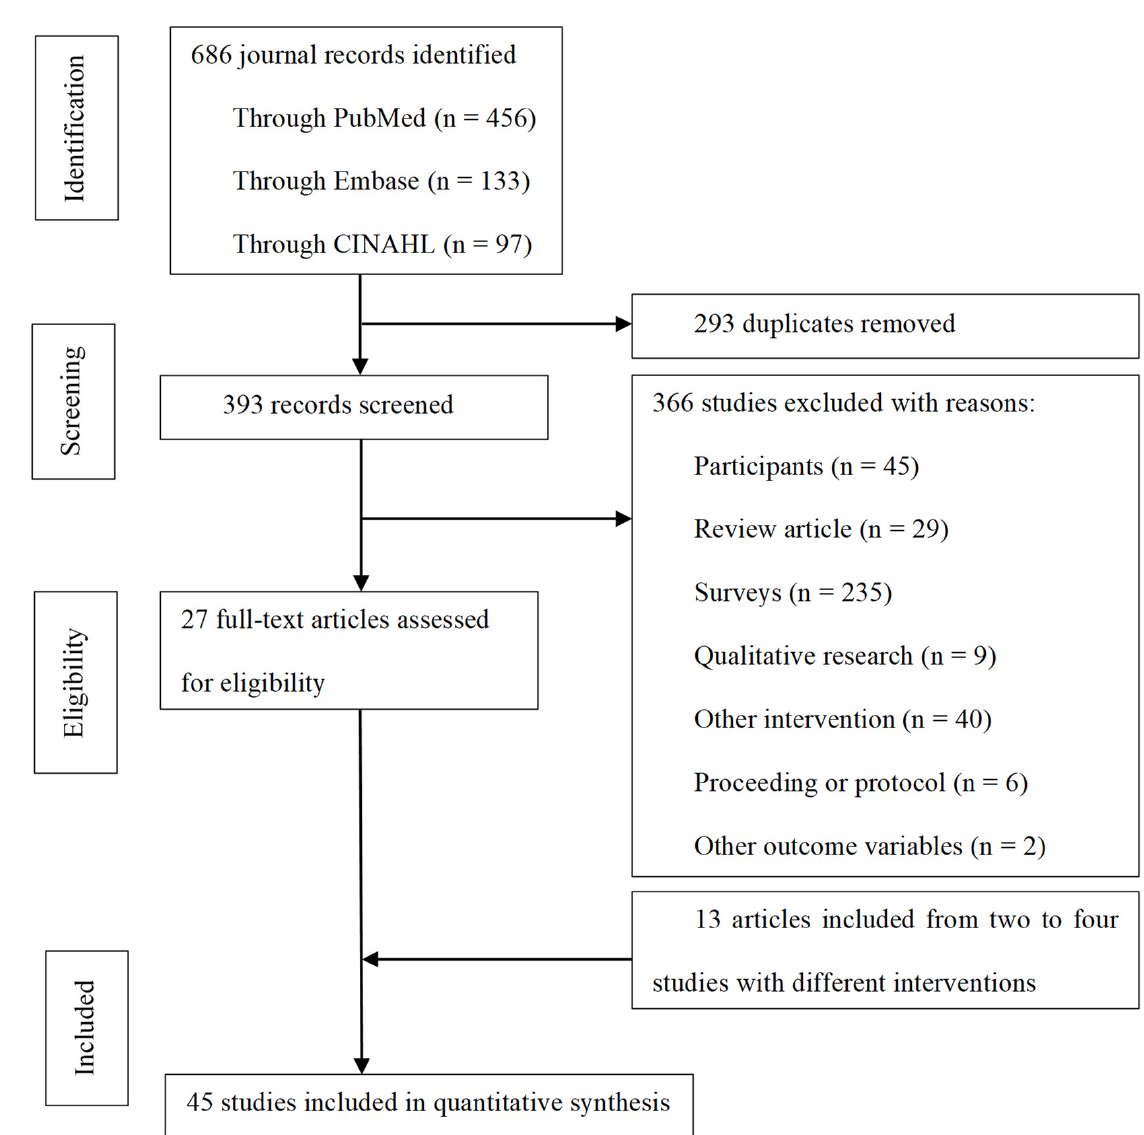
Figure 1. Search outcomes.